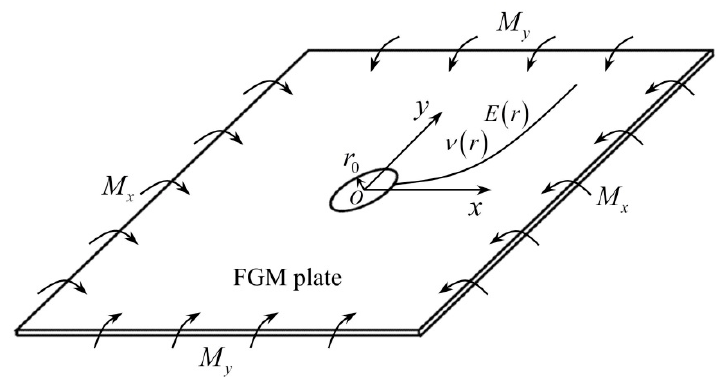
Figure 1. A functionally graded thin plate with a circular hole subjected to remote bending moment.